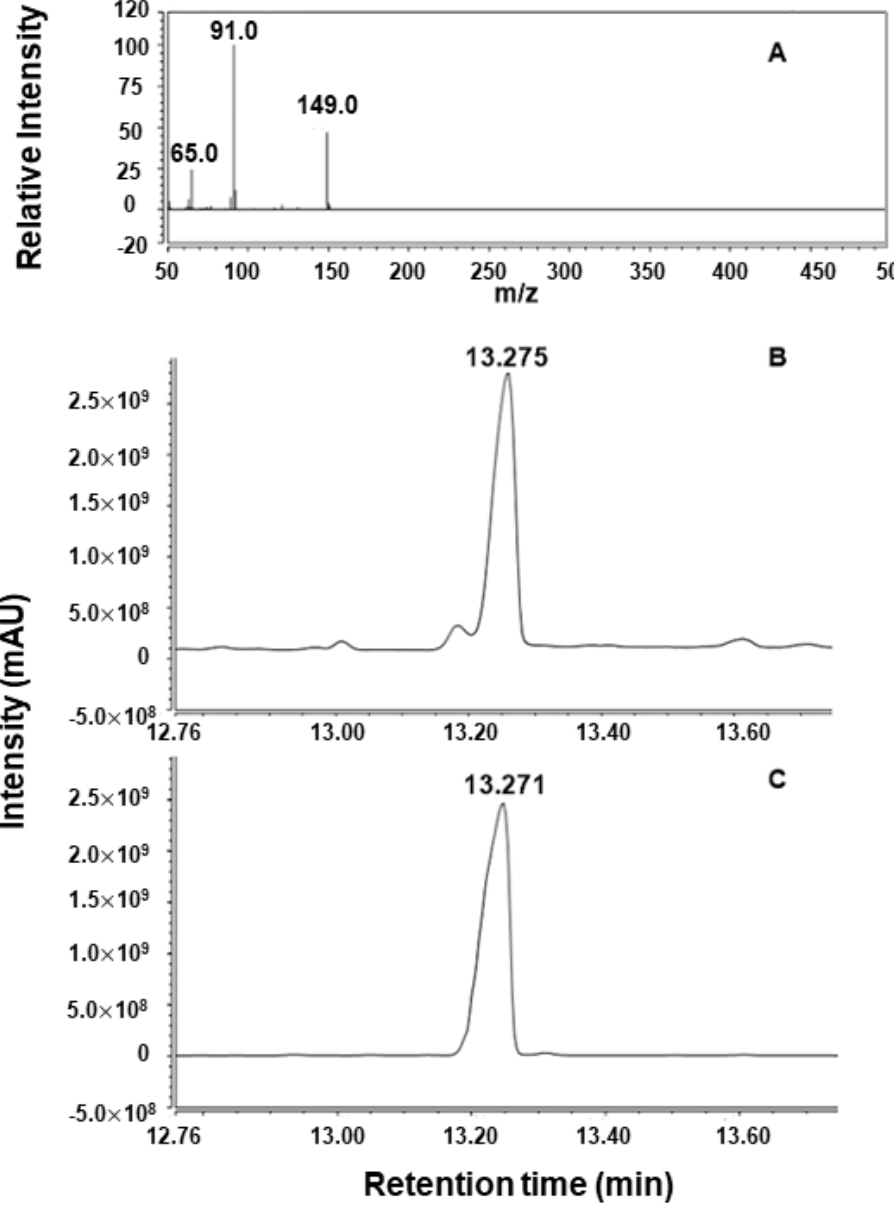
Figure 2. Determination of enzymolysis product from GLS. ( A ) Mass spectrum of enzymolysis prod- uct from GLS, ( B ) gas chromatogram of enzymolysis product from GLS, and ( C ) gas chromatogram of benzyl